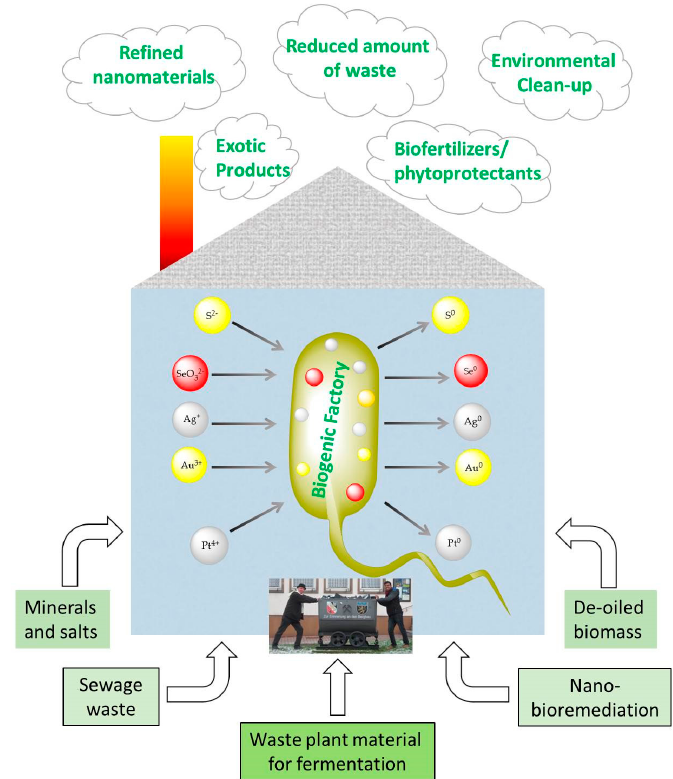
Figure 4. Schematic illustration of the biogenic factory which is able to turn biological substances, extracts, plants, algae and even waste biomass into amazing new products and nanomaterials. A particular interest resides on the added value resulting from the use and “up-cycling” of by-products and waste, such as de-oiled herbs, spent grains and coffee grounds, as these materials initially are not only food-grade but otherwise would go to waste and hence impact negatively on the environment. Photo taken at Hassel (Saar) and kindly provided by Elizabeth Jacob.